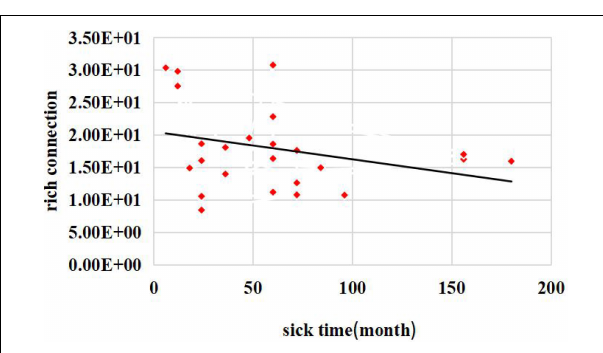
FIGURE 5 | Relationship between disease duration and the number of rich